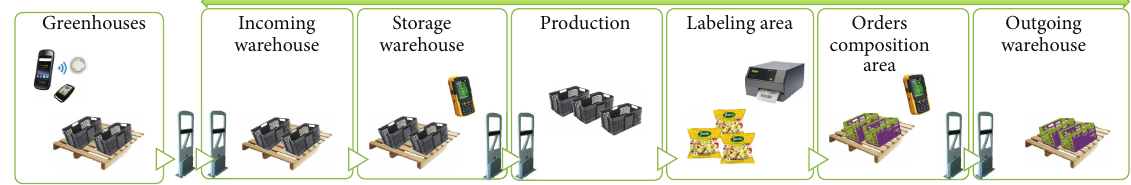
Figure 3: Main RF devices introduced by the reengineered